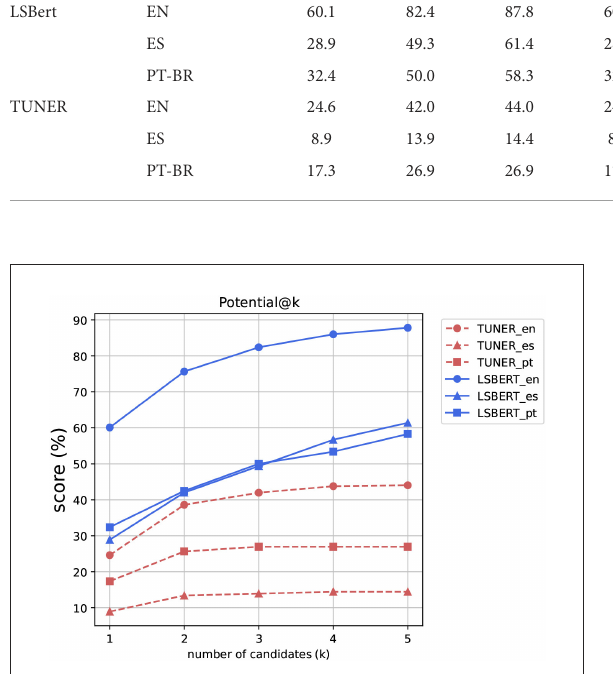
FIGURE2 Precision@k, k =